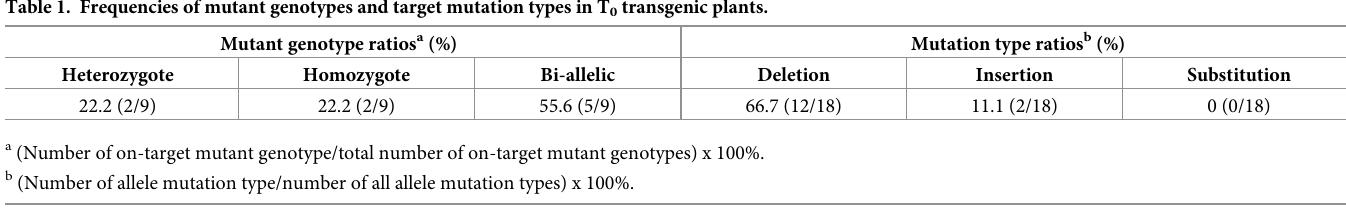
Table 1. Frequencies of mutant genotypes and target mutation types in T 0 transgenic plants. Mutant genotype ratios a (%)